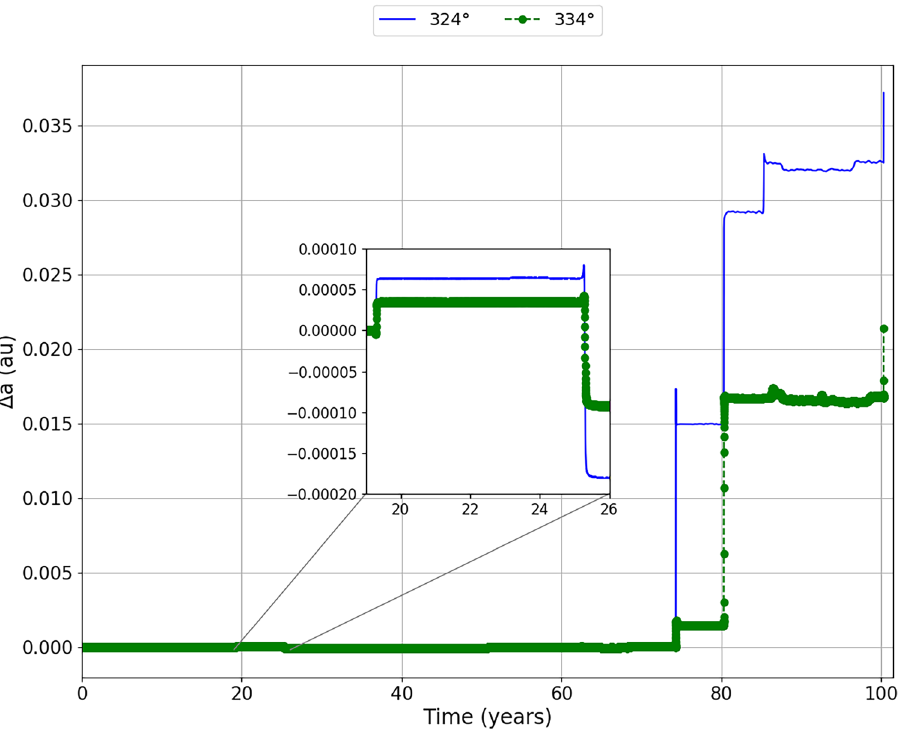
Figure 8. Difference of the semi major axis with respect to time ( (cid:31) a) for the impulse applied at the mean anomalies of 324° (blue line) and 334° (green line). We zoomed in on the region corresponding to the second largest close encounter to better visualize the variations of the semi-major axis difference of the